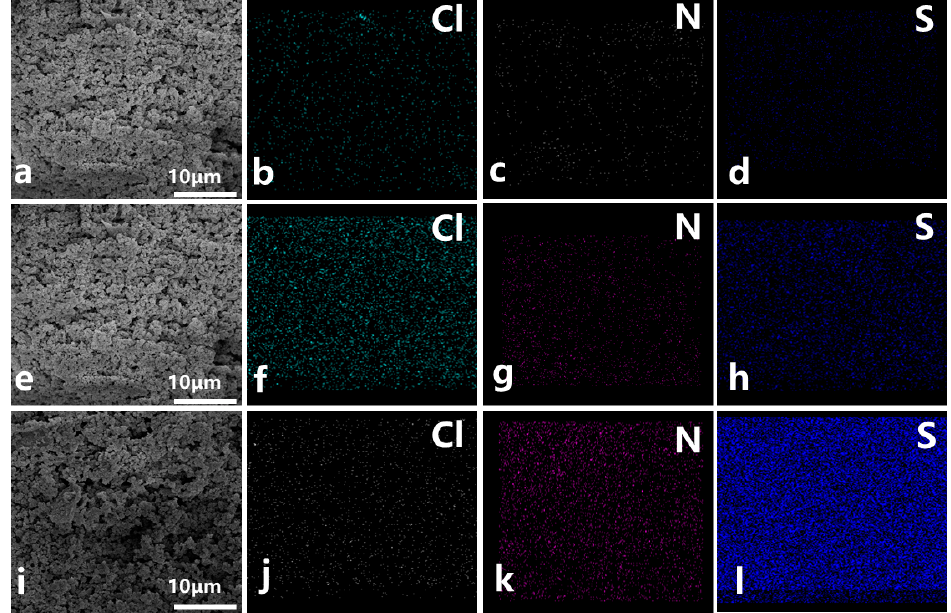
Figure 2. FE-SEM images of ( a ) HCP pitch , ( e ) HCP pitch –CH 2 –Cl, and ( i ) [HCP pitch –Im–Pros][Tos] catalyst. Element mappings of HCP pitch , HCP pitch –CH 2 –Cl, and [HCP pitch –Im–Pros][Tos]: ( b , f , j ) Cl, ( c , g , k ) N, and ( d , h , l ) S, respectively.